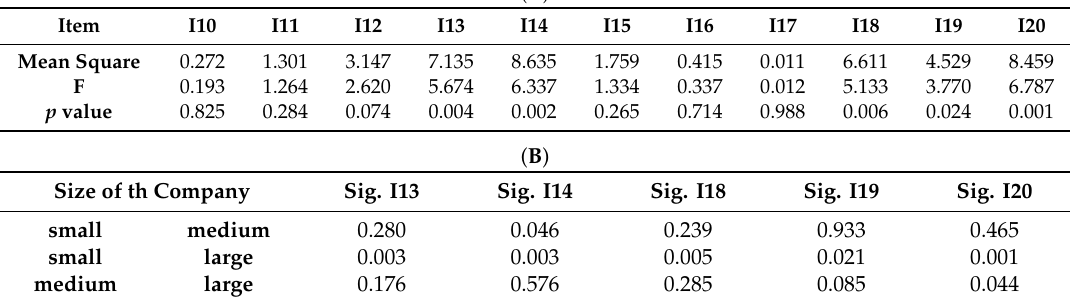
Item I10 I11 Mean